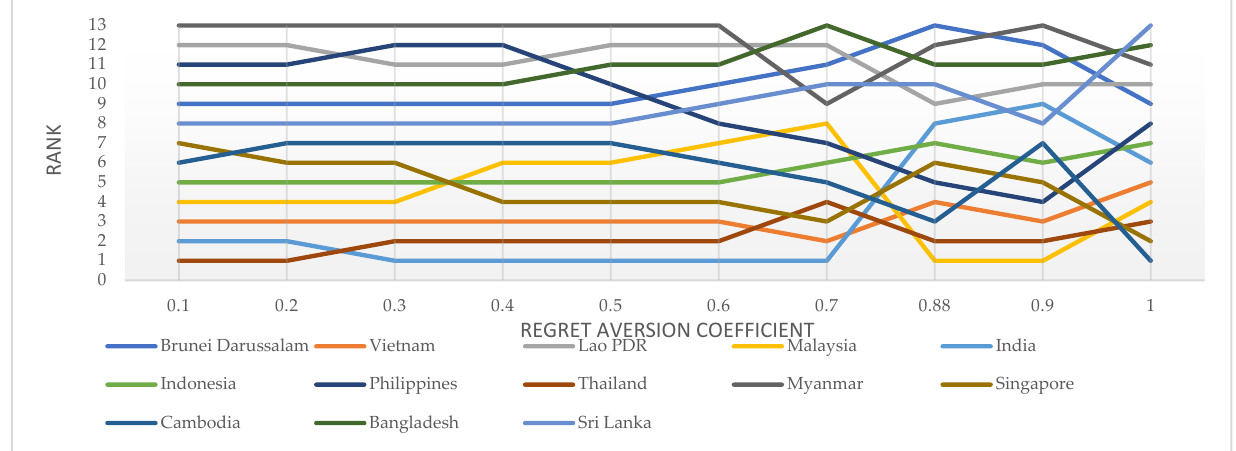
Figure 9. Regret-aversion coefficient sensitivity analysis.